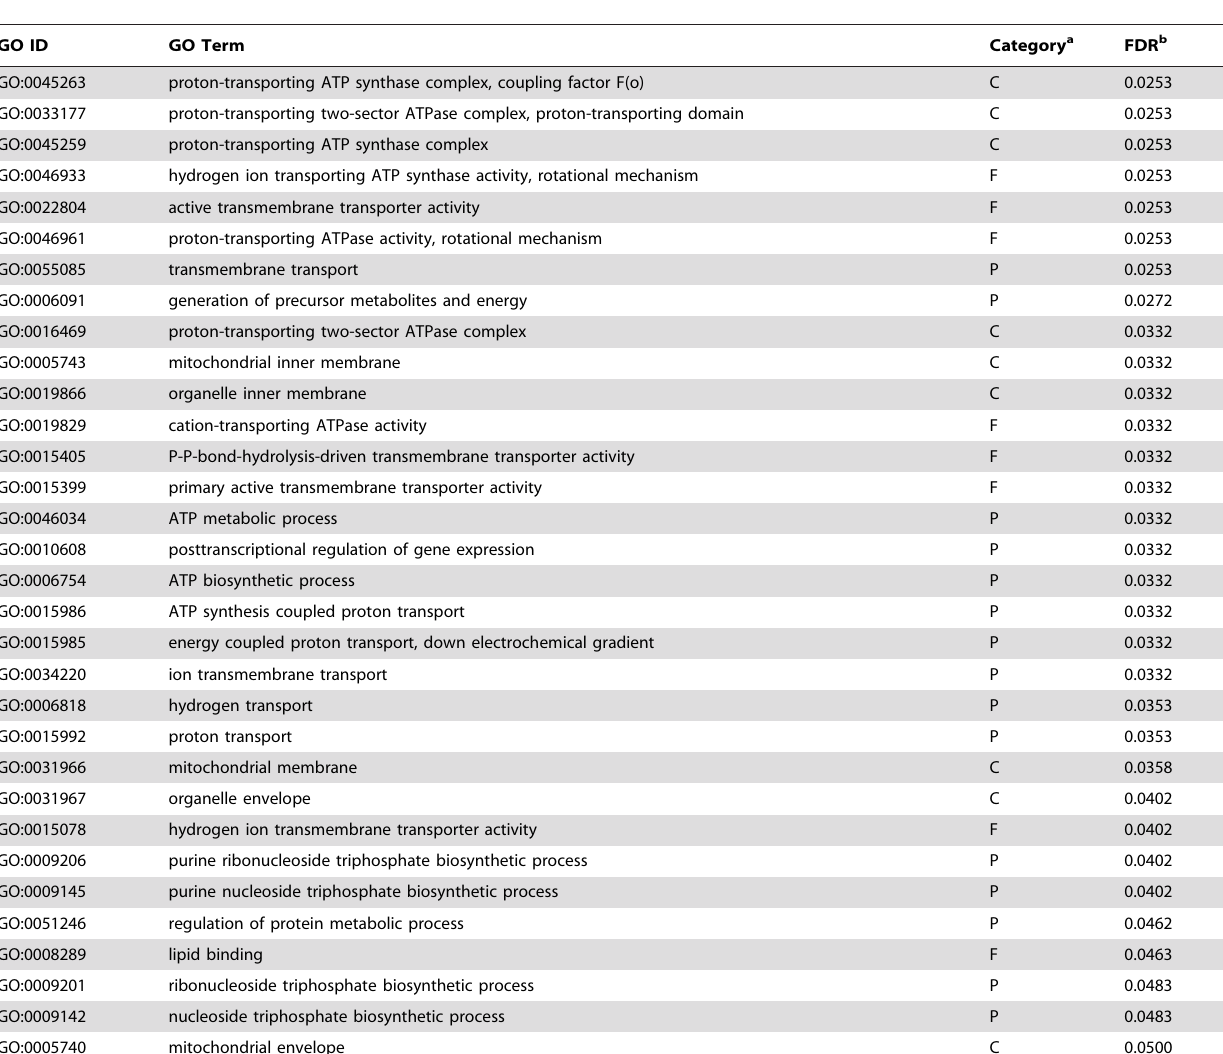
Table 1. Significantly over-enriched gene ontology (GO) categories, assigned using the standard GO vocabulary, among features with calculated half-lives of at least 3